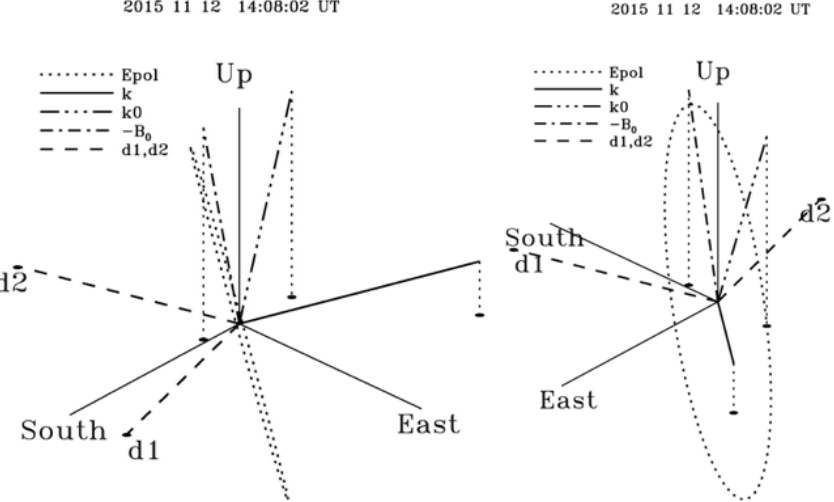
Figure 3. Direction of the pump wave vector ( k ) detected by the RRI on CASSIOPE at an altitude of 553km as viewed from two angles (14:08:02UT on 12 November 2015, corresponding to the plasma profile in Fig. 1). Also shown is the direction of the straight line between Heating and CASSIOPE ( k 0 ), B 0 and the two receiver dipoles ( d 1 , d 2 ). The vertical dotted lines indicate the projection of the vectors on the horizontal south–east plane. The dashed ellipse indicates the polarization of the wave electric field and the right diagram is from approximately normal to that ellipse. The DOA calculations were done with f p = 2 . 00MHz and f e = 1 . 20MHz at the CASSIOPE altitude.